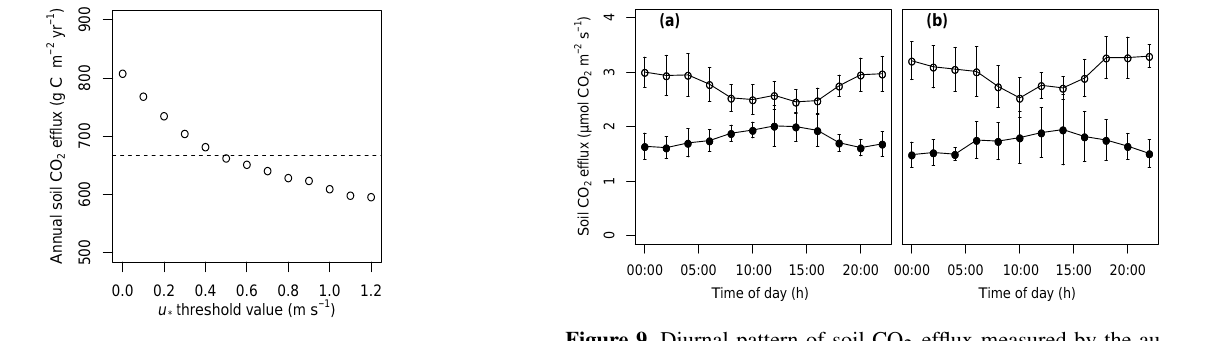
Figure 7. Estimates of annual soil CO 2 efflux in response to increasing the friction velocity ( u ∗ ) threshold values for the automated chamber measurements during the 1-year campaign. The straight dashed line shows the annual soil CO 2 efflux of 666.6gCm − 2 year − 1 based on the manual measurements.